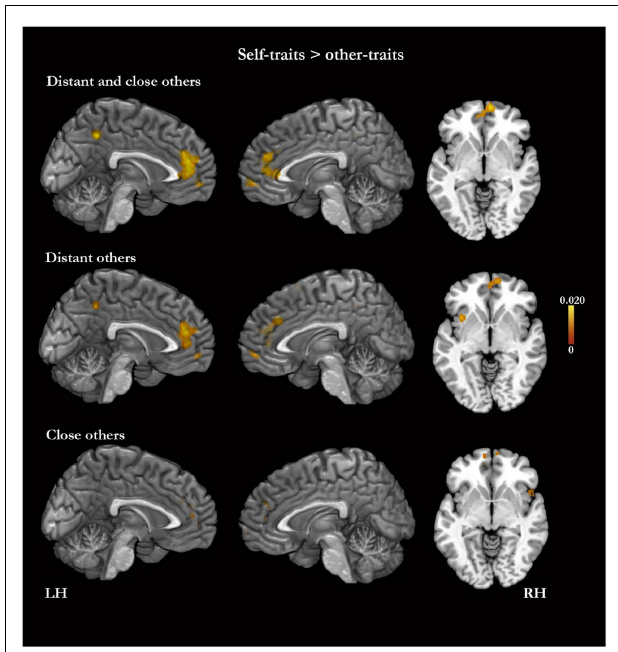
FIGURE 3 | Meta-analysis of activation foci for self-traits compared with other-traits in relation to both kinds of other (148 foci; 22 experiments), to distant kinds of other (98 foci; 15 experiments), and to close kinds of other (50 foci; 10 experiments)